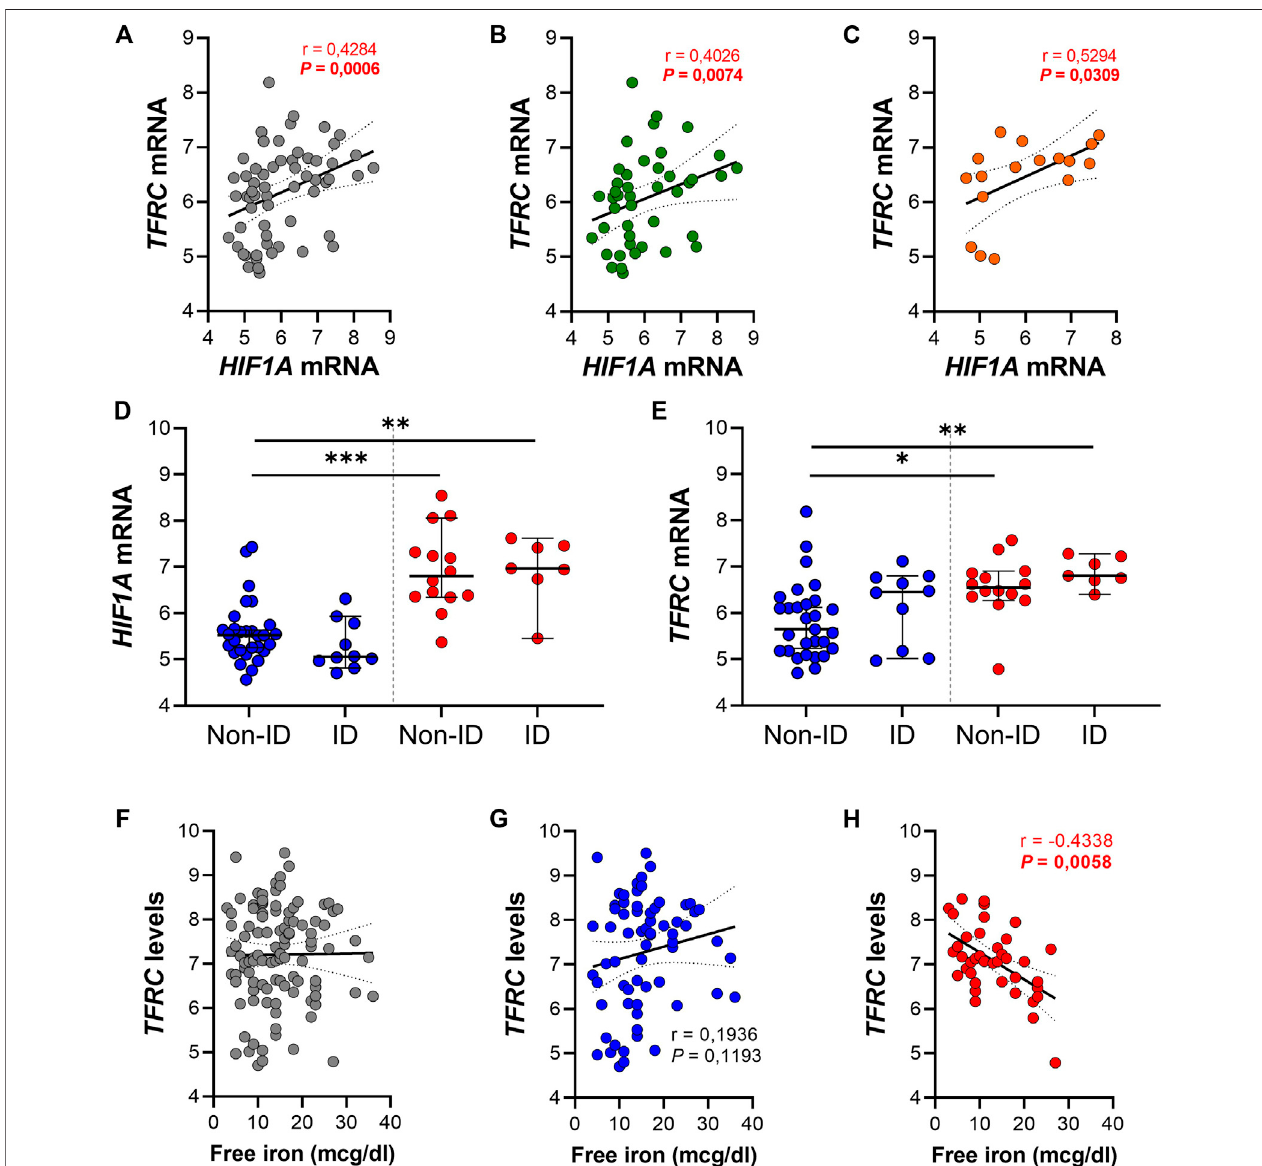
FIGURE5|(A – H) Spearmancorrelationanalysisbetweengeneexpressionlevelsof TFRC and HIF1A in (A) ilealbiopsiesandilealbiopsiesfrom (B) IBDnon-IDand (C) IBD-IDpatients.Differentialgeneexpressionof (D) HIF1A and (E) TFRC inilealbiopsiesfromnon-in fl amed(bluedots)andin fl